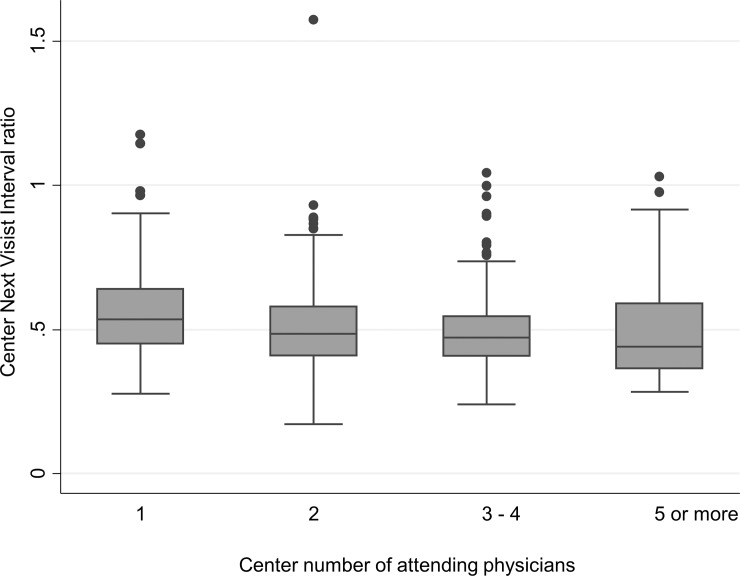
Boxplot of Center Next Visit Interval (NVI) ratio by number of physicians attending the Anticoagulation Clinic, showing an inverse relationship (p<0.0001 for trend).